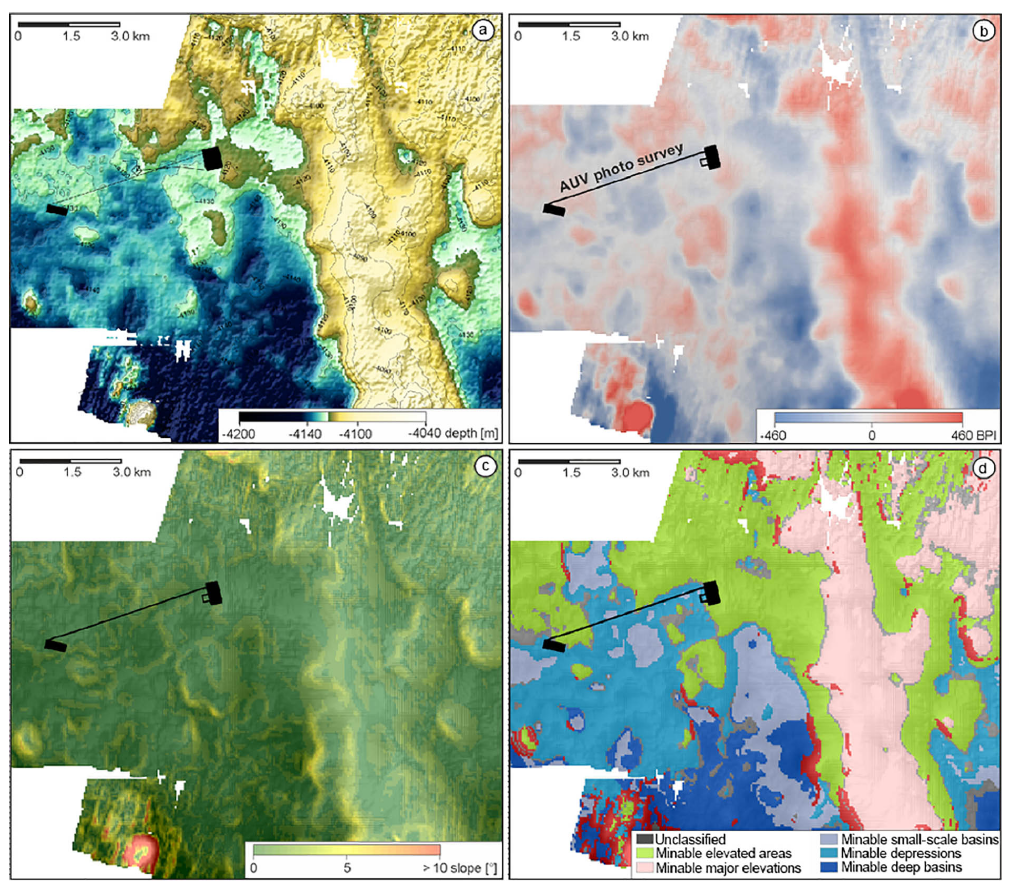
Figure 3. Overview maps for the geological setting of the AUV study area. (a) Bathymetry; (b) BPI with scale factor 2750 (cell size: 55m, inner radius: 10 cells, outer radius: 50 cells); (c) slope (in degree); (d) terrain classification based on the classification dictionary in Table A3. Black lines indicate the track of AUV Dive 168 prior the EBS deployment (a) and the locations of usable photos from this dive ( b , c and d ). See Fig. 2 caption for the definition of mineable